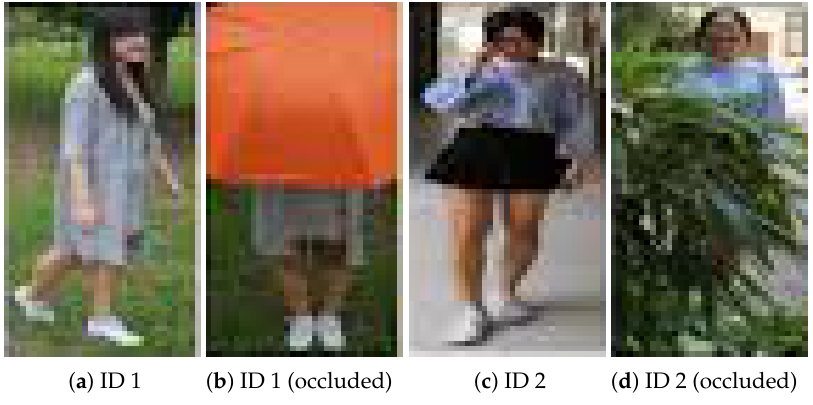
Figure 1. Some common problems found in object